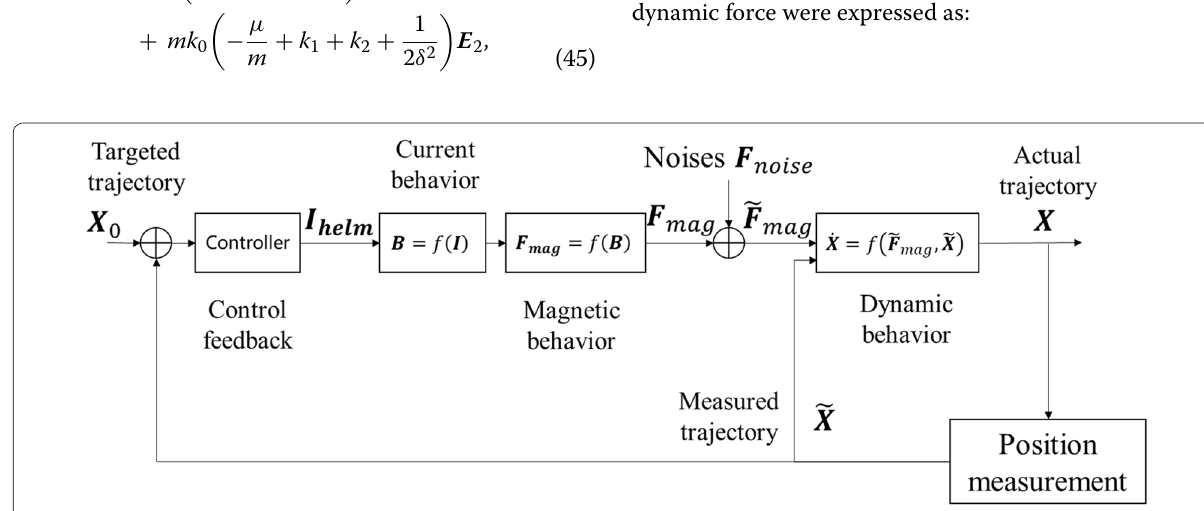
Figure 14 Schematic of the closed loop motion